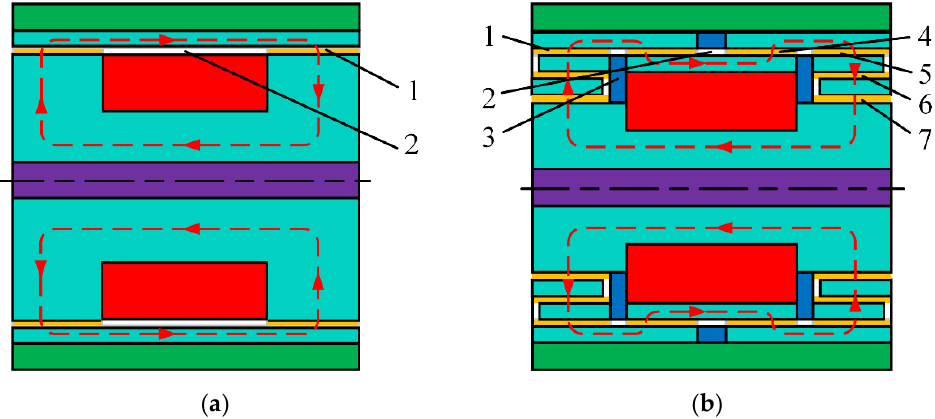
Figure 1. Structural schematic of the MR damper: ( a ) Traditional MR damper; ( b ) Proposed MR damper. 1. Magnetic activated region, 2. Non-flux region, 3. Non-magnetic material, 4. Second outer gap, 5. First outer gap, 6. Middle gap, 7. Inner gap.